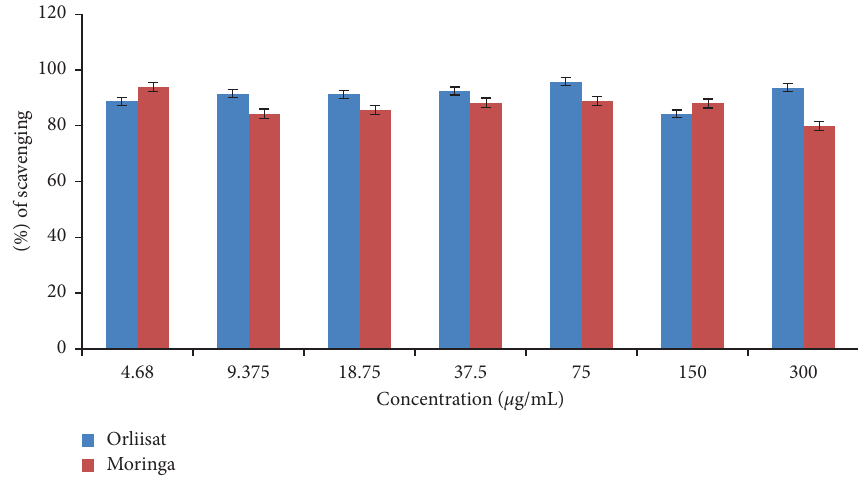
Figure 3: Efect of M. oleifera leaf extract on α -lipase